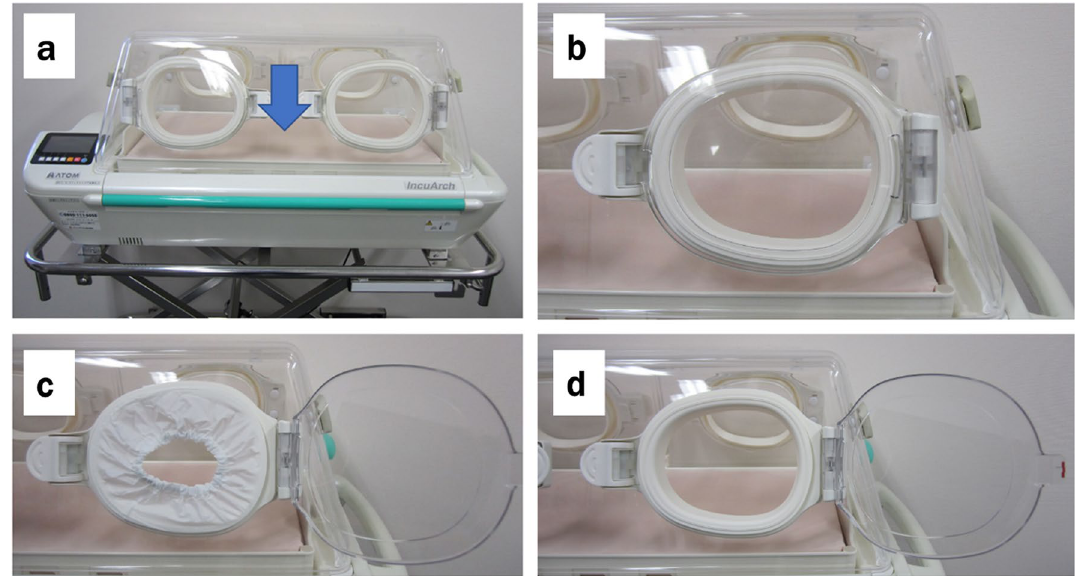
Figure 1. Pictures of the transport incubator. ( a ) Overall view; ( b ) the snap-open access ports are closed (“closed” condition); ( c ) the two snap-open access ports on the same side are opened, with covers attached (“covered” condition); and ( d ) the two snap-open access ports on the same side are opened, without covers attached (“opened” condition). Pictures taken by Takahiro